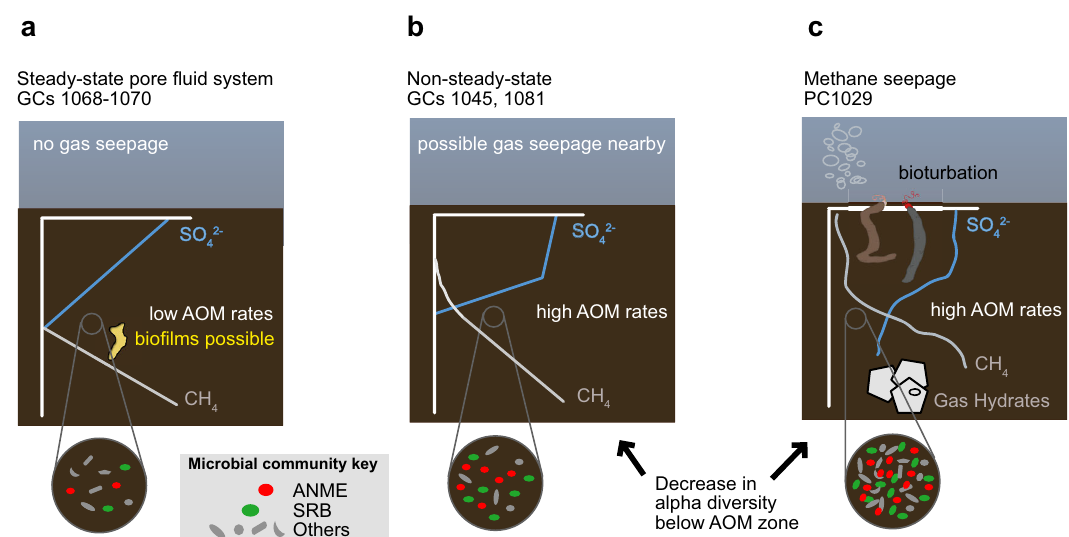
Fig. 8 Conceptual depiction of microbial community changes concurrent with distinct states of methane dynamics at Storfjordrenna gas hydrate mounds. Panels a , b , and c illustrate data shown in Figs. 3 – 5, respectively. Methane and sulfate pro fi les are shown in gray and blue lines, respectively, with microbial community changes indicated by blowup circles. ANME and SRB represent red and green ovals, with other bacteria and archaea in gray (shapes representing the diversity of other taxa). a Steady-state sulfate pro fi les suggest a weak methane in fl ux, and low rates of AOM are observed at the SMT. Stable conditions may allow for higher microbial diversity in sediment communities and the growth of macroscopic bio fi lms. b A concave-up bend in porewater sulfate suggests recent methane migration into the sulfate reduction zone consistent with a pulse of methane beginning hundreds of years ago (approx. 290 years ago at GC1045, Fig. 2f, g). Methane travels upward throughout the sediment column, and ANME/SRB growth follows with less than a year of lag time, driving down alpha diversity. c Methane seepage stimulates high rates of AOM and densities of ANME/SRB. Sul fi de fl uxes from AOM- coupled sulfate reduction are suf fi cient to support frenulate siboglinid tubeworms, which may distribute sulfate across the upper several cm of sediment, increase redox gradients in underlying sediments, and further ANME/SRB